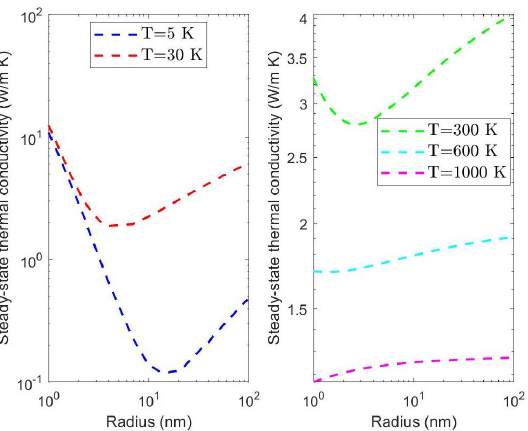
Figure 9. Steady-state thermal conductivity versus R , for fnp = 2% and T = 5, 30, 300, 600, 1000